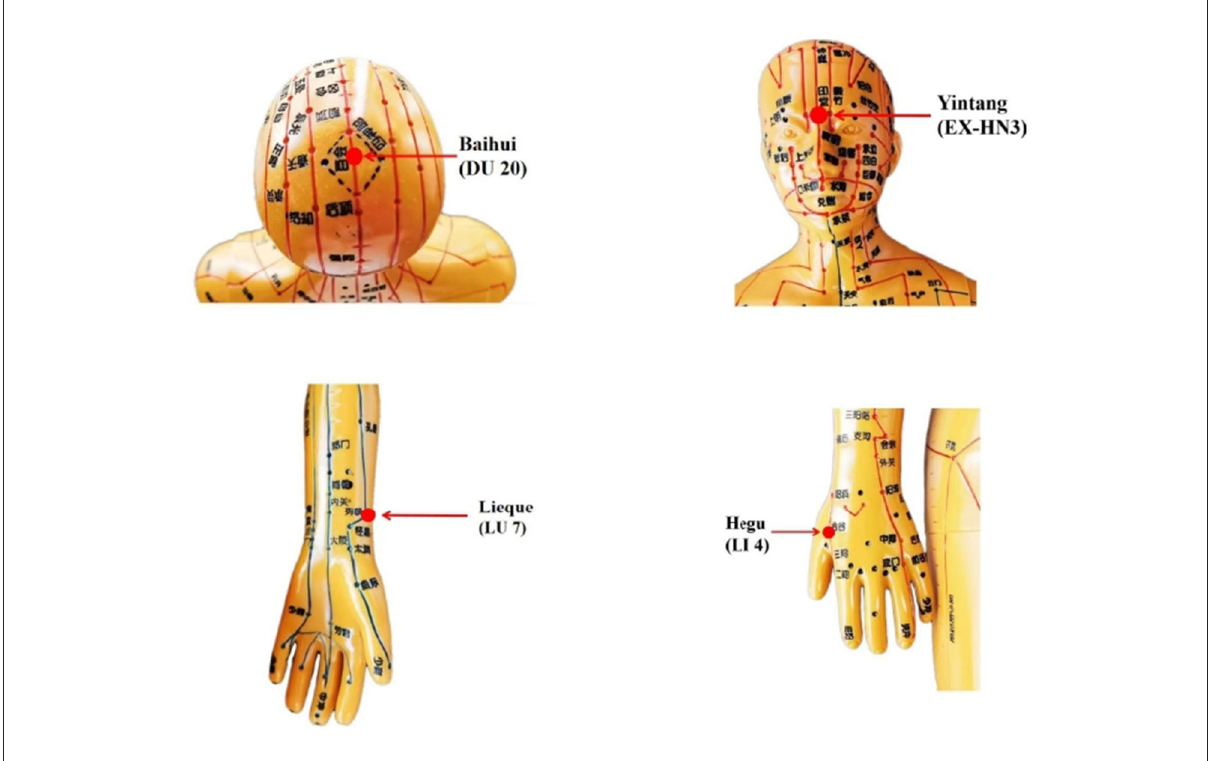
FIGURE2 Acupuncture